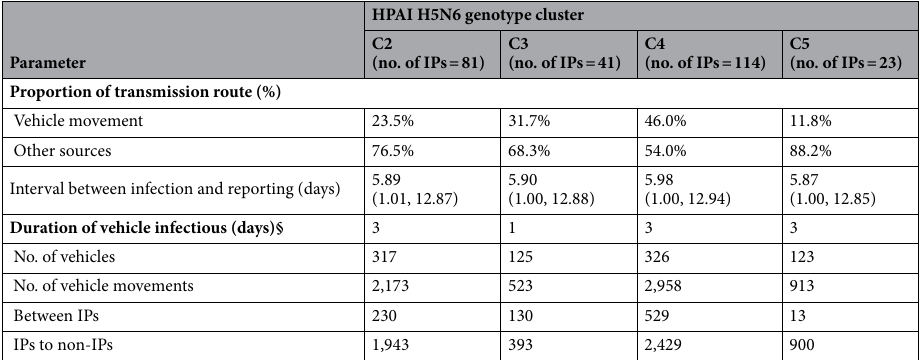
Table 3. Contribution rate of potentially contaminating vehicle movement and other sources of HPAI H5N6 infection at infected premises that belong to each phylogenetic cluster. With the force of infection was calculated based on the posterior marginal distributions of each parameter, the proportion of potential route of transmission contributing to HPAI H5N6 infection in IPs that belong to a specific phylogenetic cluster was obtained by simulating a binomial trial with two possible outcomes (e.g., vehicle movement and other sources of infection) to compute. The distribution was obtained by simulating values from the Gamma distribution, based on parameters α and β randomly sampled from their joint distribution. Based on DIC value, the preferred model between one day and three-day infectious duration for vehicle movements originating from a specific genotype of IPs was selected. HPAI highly pathogenic avian influenza, IPs infected premises, DIC deviance information